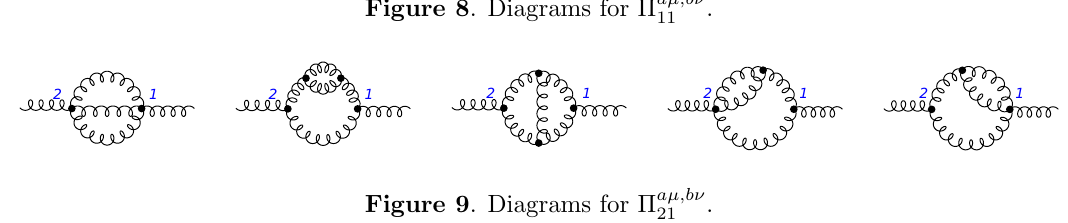
Figure 8 . Diagrams for (cid:5) a(cid:22);b(cid:23)